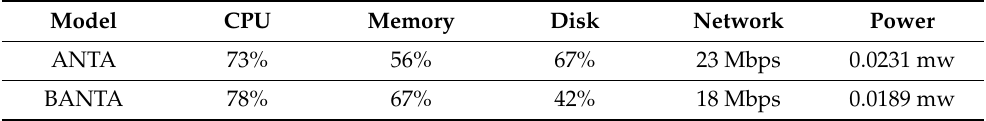
Table 5. Resource utilization metrics of the ANTA and BANTA methods.